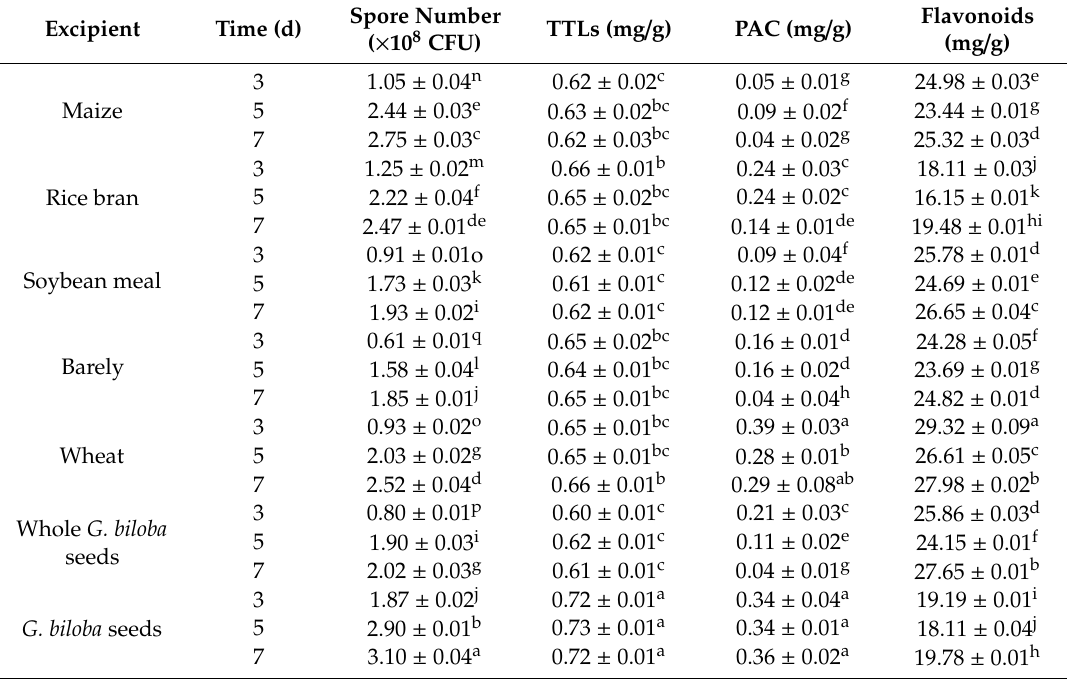
Table 1. E ff ects of the excipients on the spore number, TTLS, PAC, and flavonoids in the fermented G. biloba leaves. Excipient Time